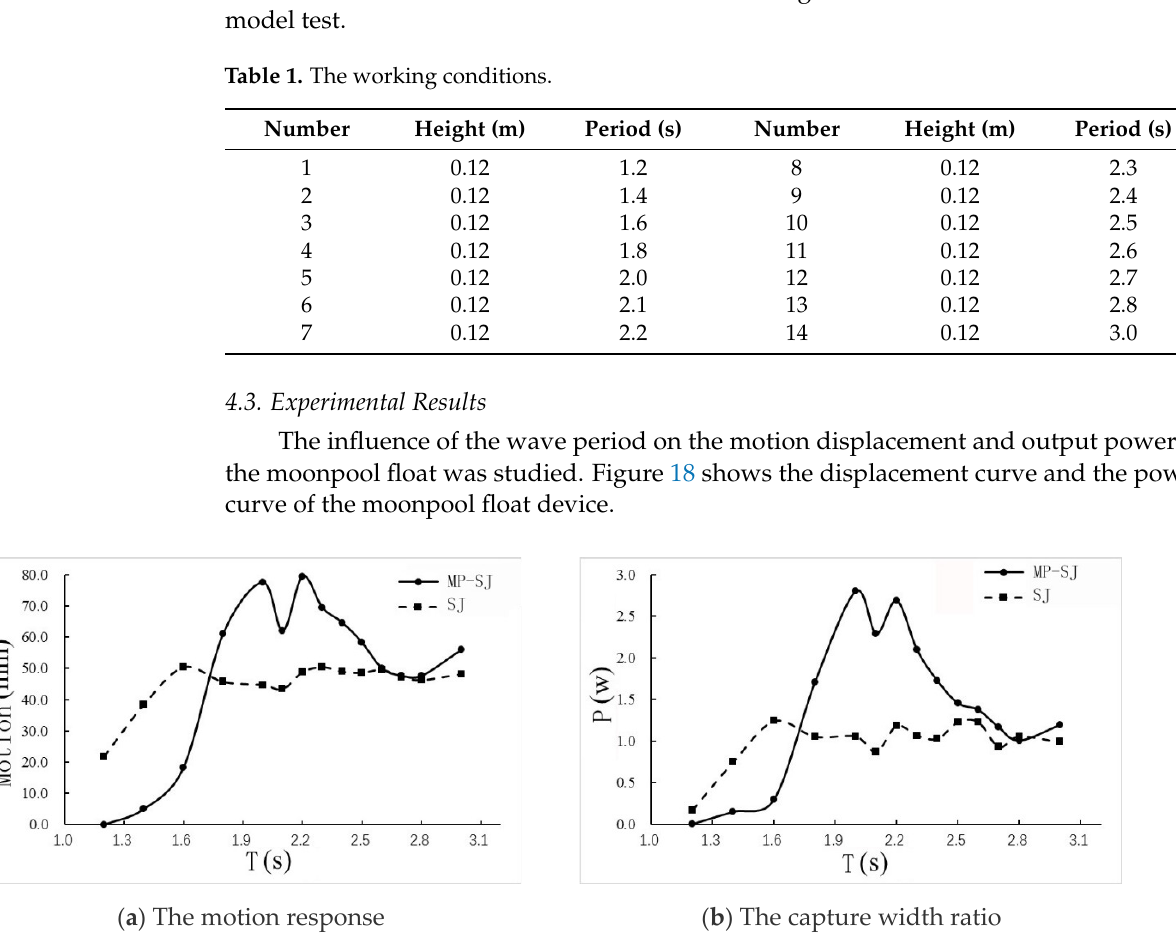
Figure 18. The motion response and capture width ratio with different wave periods.